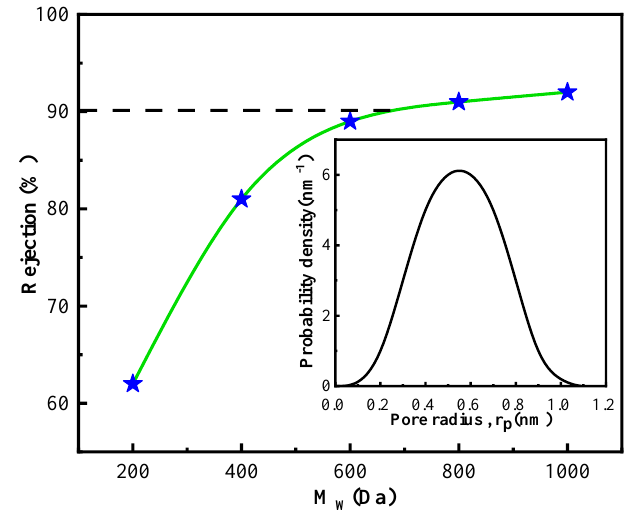
Figure 14. Molecular weight cut − off of IP − ZrO 2 /BC − NFM. NFMs can effectively remove polyvalent salt ions and dye molecules in water, and they are mostly used in water treatment applications such as seawater desalination and softening of drinking water [37]. In this study, 500 mg/L of NaCl, Na 2 SO 4 , MgCl 2 , and CaCl 2 and 1000 mg/L of MB (MB 799) and CR (CR 696.663) were used to test the separation performance of IP–ZrO 2 /BC–NFM at a pressure of 0.5